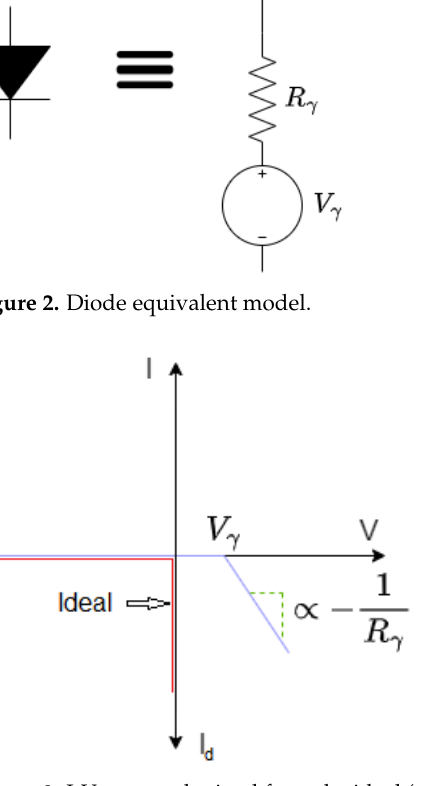
Figure 3. I-V curves obtained from the ideal (red) and non-ideal (light blue) diode equivalent